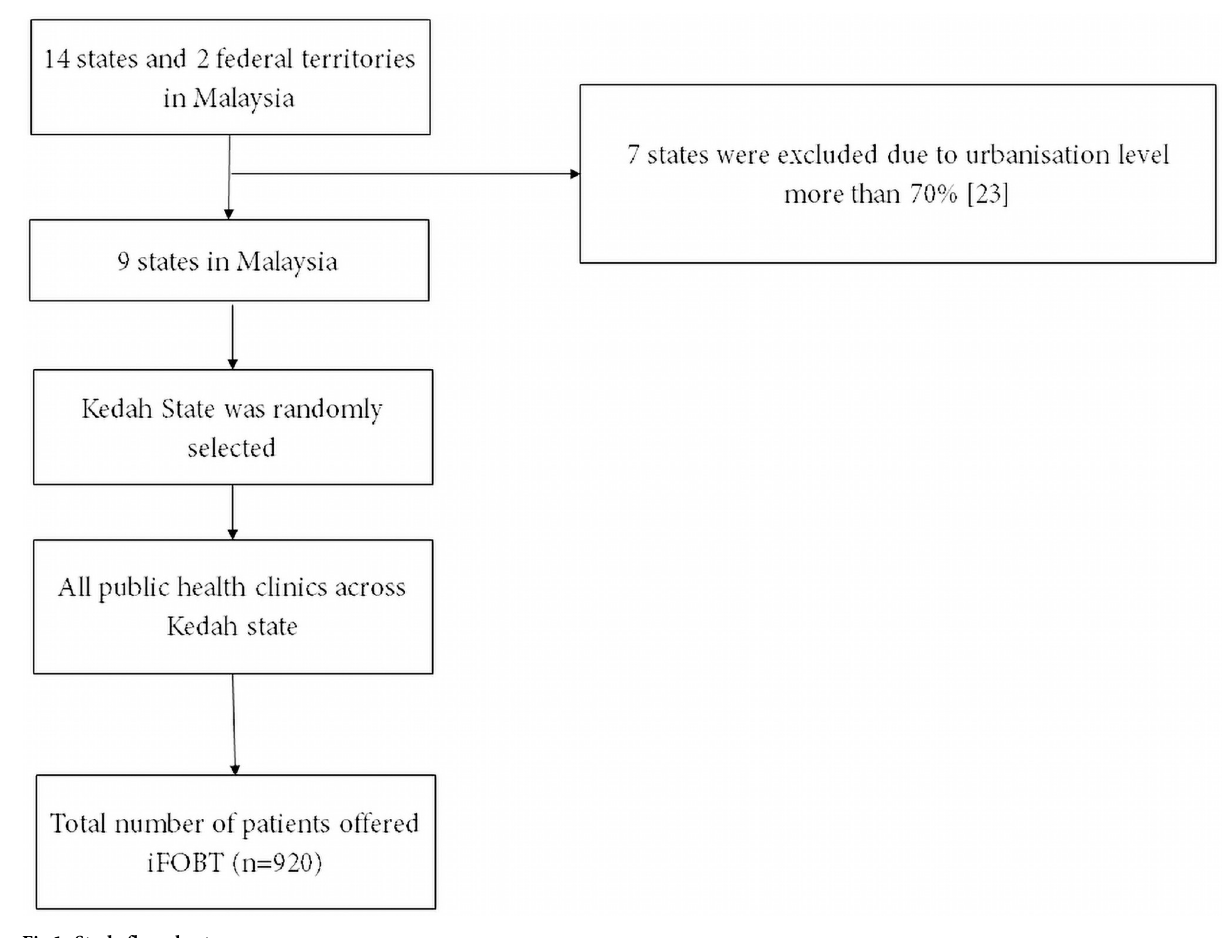
Fig 1. Study flow